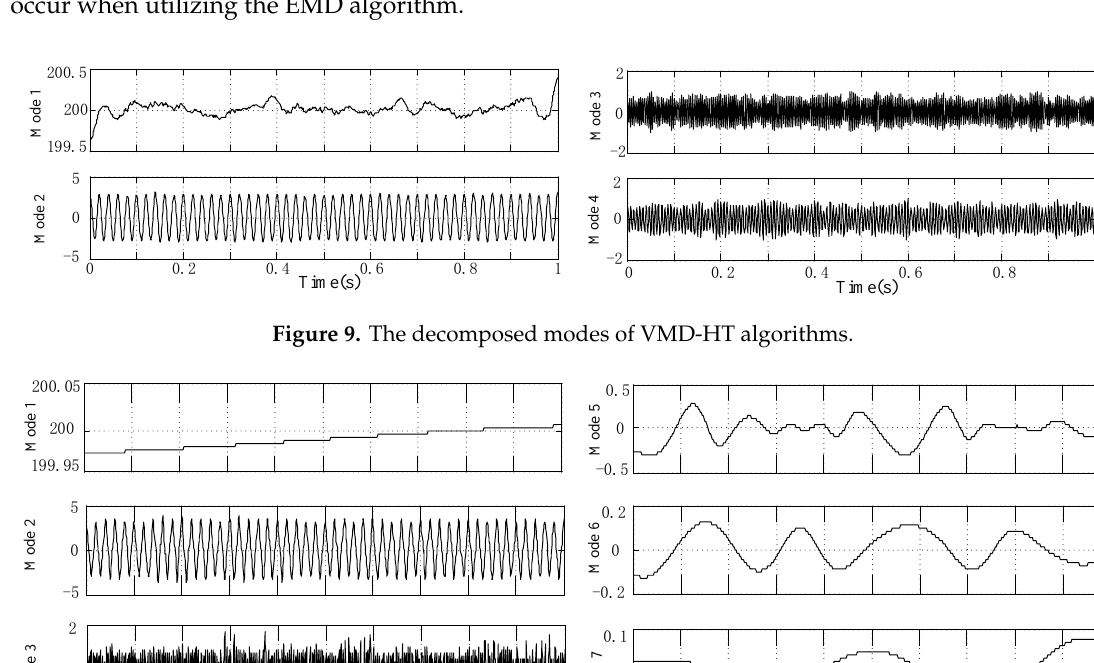
Figure 10. The decomposed modes of EMD algorithms.